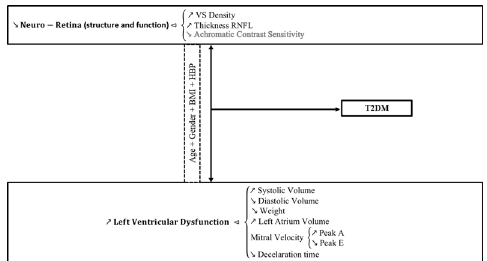
Fig 3. Graphical abstract highlighting our main results. Prediction of left ventricular dysfunction in type 2 diabetes (T2DM) based on independent visual dysfunction, moderated by common risk factors such as age, gender, body mass index (BMI) and presence/absence of drug controlled arterial hypertension